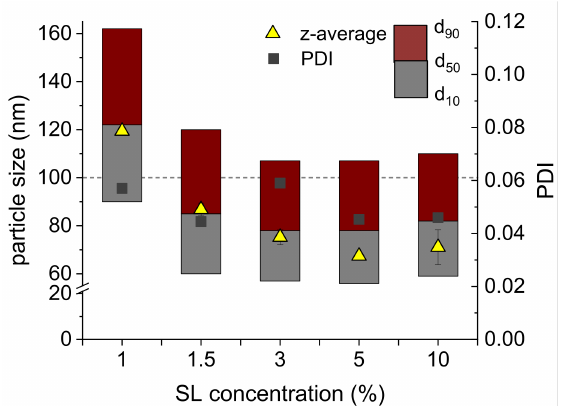
Figure 3. Particle size distributions (d 10 , d 50 and d 90 values, n = 1), z-average diameter and PDI ( n = 2) of 10% MCT nanoemulsions prepared by PME through Anodisc ™ 20 nm membranes (0.2 mL/s) dependent on the SL